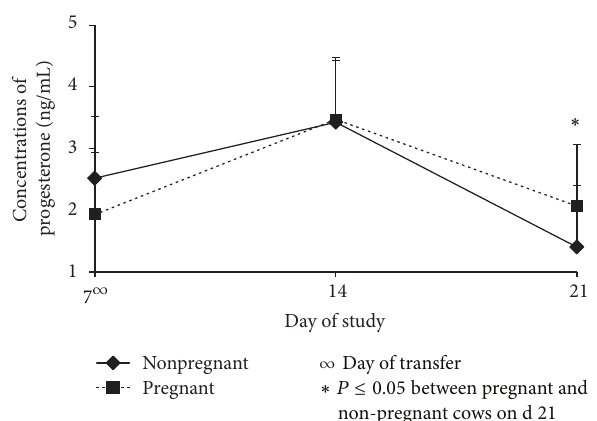
Figure 1: Concentrations (Mean ± SEM) of progesterone in preg- nant and nonpregnant cows on d 7, d 14, and d